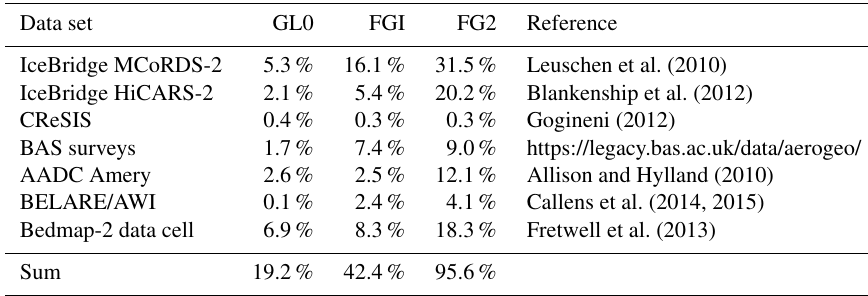
Table 1. Table 1. Data sources and percentages for radio-echo-sounding data used to compile flux